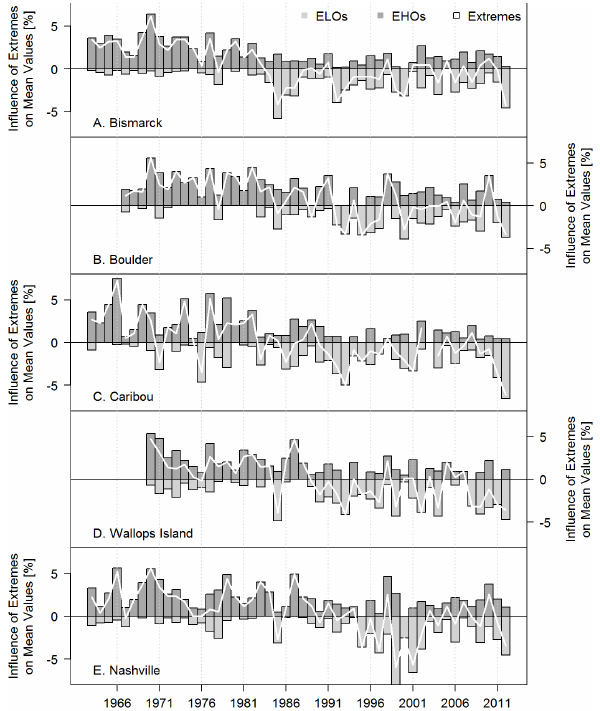
Figure 9. As Fig. 8 but for spring